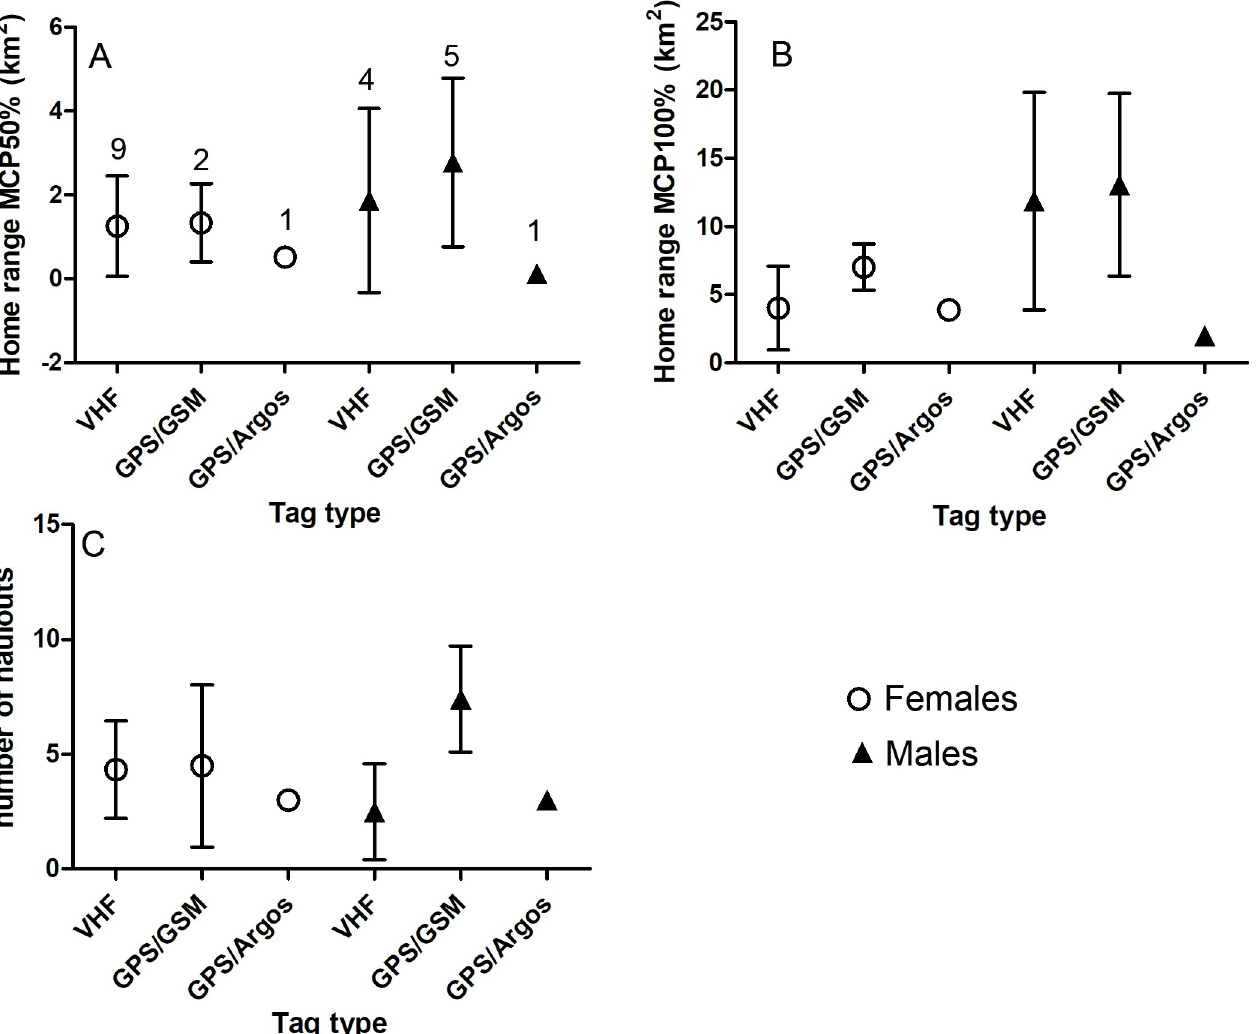
Fig 1. A-B) Sizes of the home ranges (km 2 ) and C) number of the haul outs of the adult male and female Saimaa ringed seals tracked with different tag types. VHF = very high frequency radio tags, and GPS/GSM and GPS/Argos = satellite-based tags. The number of animals tracked with each tag is shown above the plots in Figure